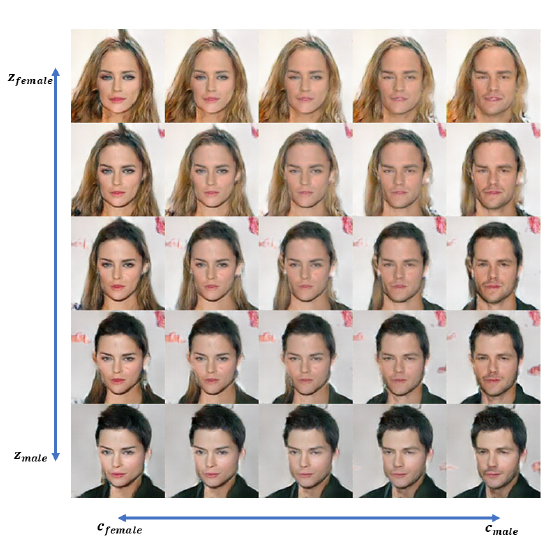
Figure 5. Latent code